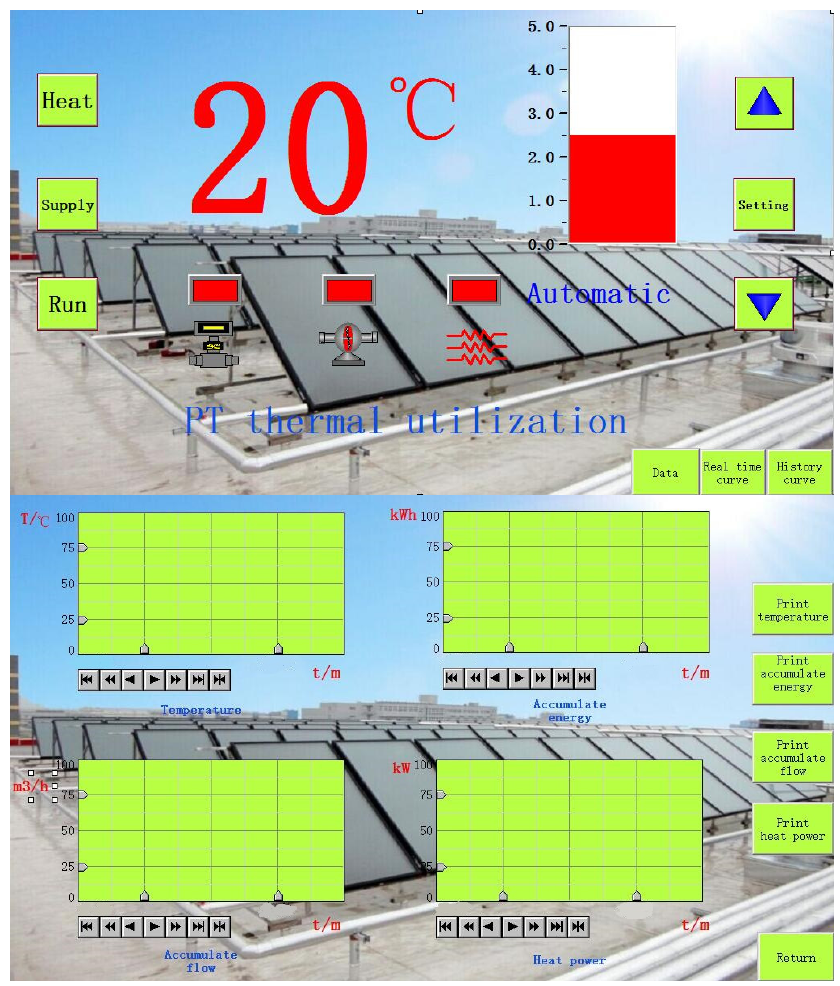
Figure 9. The interfaces of monitoring and data acquisition of PT thermal utilization. Energies 2017 , 10 , 507